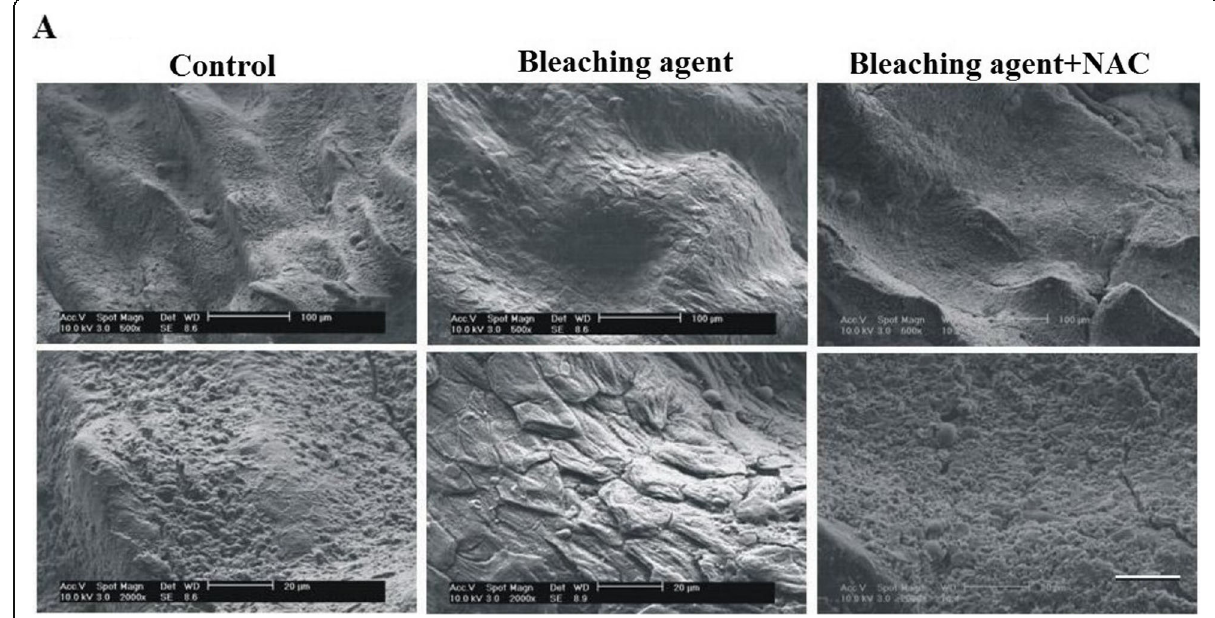
Fig. 2 NAC protects the gingival cells from undergoing cell death in the presence of bleaching agents in rats. 8-week old male rats were divided into three groups; No bleaching agent- control (left panel) ( n = 3), bleaching agent only (middle panel) ( n = 3) and bleaching agent with NAC (right panel) ( n = 3). Four hours after application, the palatal tissues were extensively washed with sterilized saline, and the tissues were removed surgically and treated with 0.25% trypsin-EDTA and 0.1% collagenase to prepare single cell suspensions as described in the Materials and Methods section. The surface topography was analyzed using Scanning Electron Microscopy, magnification 500X and bar = 100 μ m for the upper panels and, magnification 2000X and bar = 20 μ m for the lower panels ( A